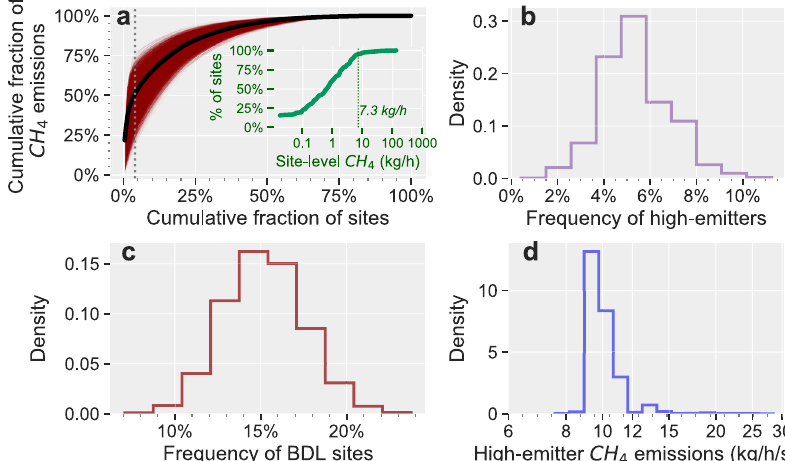
Fig. 5 Site-level CH 4 emission data for low production well sites. a Lorenz curve showing the cumulative fraction of absolute CH 4 emissions as functions of cumulative fraction of sites. The top 5% of sites (dashed vertical line) account for ~50% of total CH 4 emissions. The shaded dark red area shows the 10 4 Lorenz curves derived via a nonparametric bootstrapping of the empirical data, from which the contribution of the top 5% of sites to the total CH 4 emissions are obtained ( η , see Supplementary Fig. 22). Inset is the cumulative distribution function for site-level CH 4 emissions, with a dashed vertical high line showing the emission rate threshold for the top 5% of high-emitting sites. b Histogram of the frequency of fi nding a high-emitting site based on 10 4 random bootstrap samples of the empirical data. c Histogram of the frequency of below-detection-limit sites. d Histogram of the central estimates of high- emitter CH 4 leakage